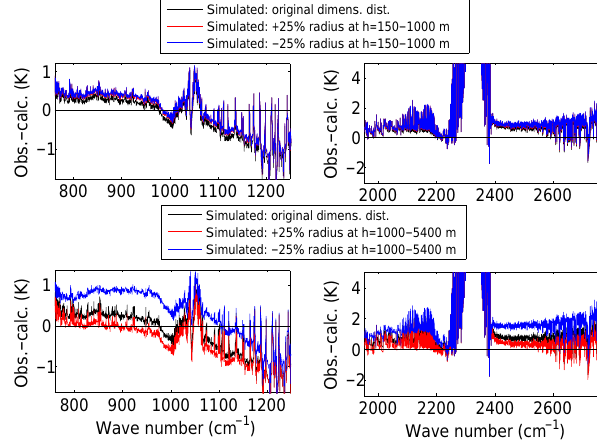
Figure 12. As Fig. 11, but for the case of 28